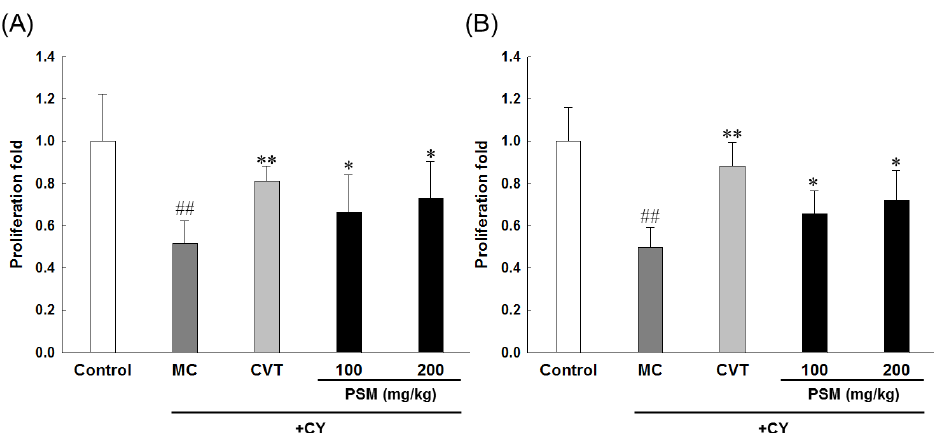
Figure 2. The effects of PSM on lymphocyte proliferation in CY-treated immunosuppressed mice. The effects on ( A ) ConA-induced T-lymphocyte or ( B ) LPS-induced B-lymphocyte proliferation. Model control (MC): CY-treated immunosuppressed mice. CVT: CVT-E200™ (200 mg/kg) was used as a positive control. Cell proliferation was measured by the MTT assay. The data are expressed as the mean ± SD ( n = 10). ## p < 0.01 vs. vehicle-treated control group; * p < 0.05, ** p < 0.01 vs. CY-treated MC